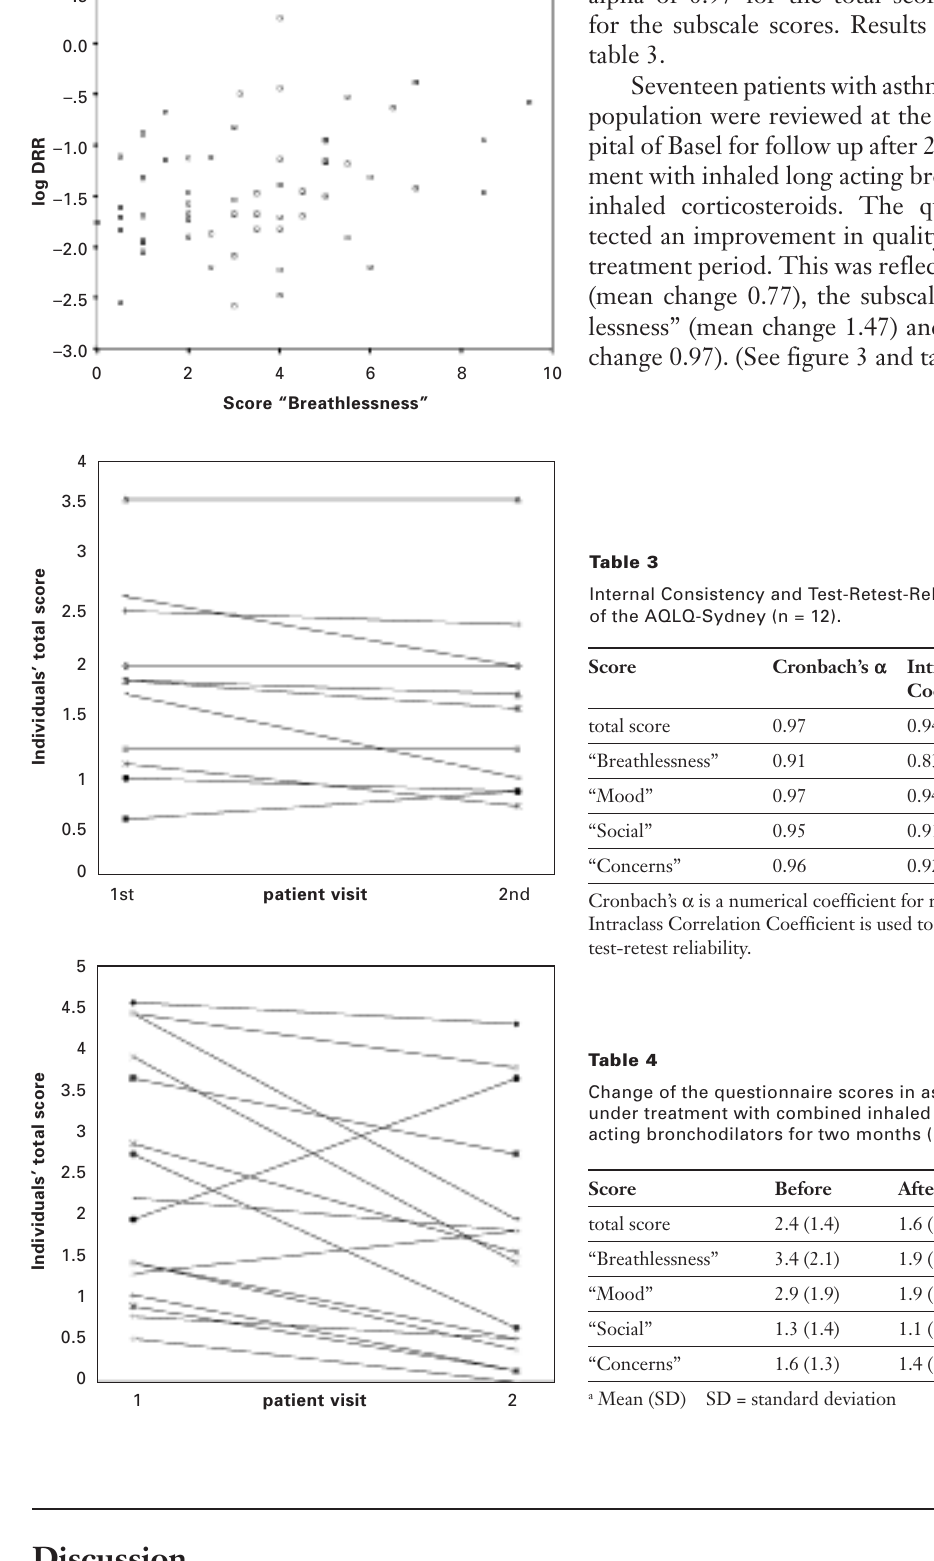
Seventeen patients with asthma from the study population were reviewed at the University Hos- pital of Basel for follow up after 2 months of treat- ment with inhaled long acting bronchodilator and inhaled corticosteroids. The questionnaire de- tected an improvement in quality of life after the treatment period. This was reflected in total score (mean change 0.77), the subscale score “Breath- lessness” (mean change 1.47) and “Mood” (mean change 0.97). (See figure 3 and table 4).